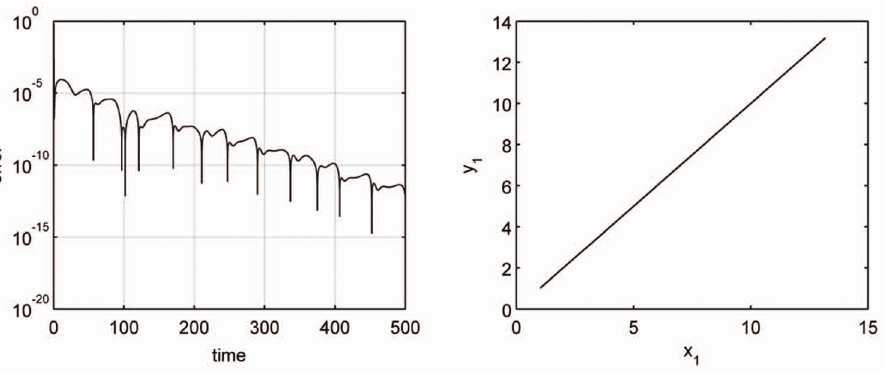
Figure 2. Synchronization between the primary and secondary systems. (left) Synchronization error, D (cid:2) aa 1 { a 1 D , between both systems for D ~ 20 . (right) The first variable of the secondary system ( y 1 ~ (cid:2) aa 1 ) versus the first variable of the primary system ( x 1 ~ a 1 ).